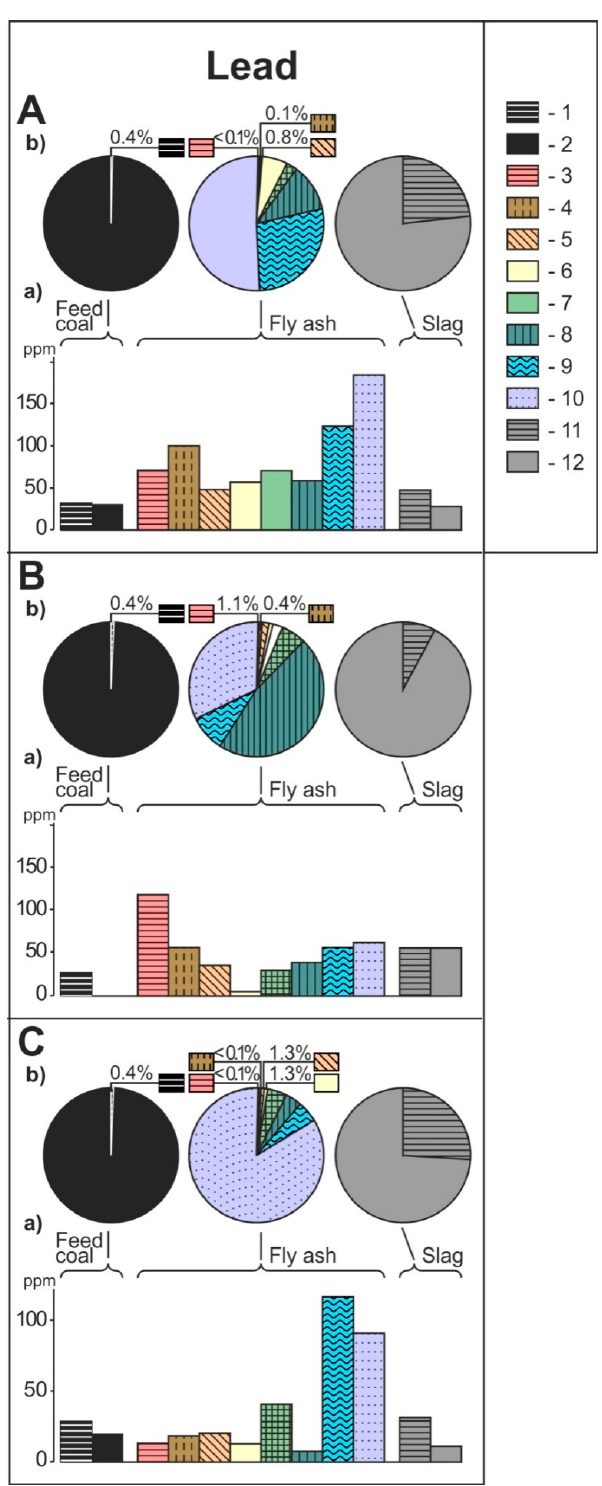
Figure 2. The distribution of element content in the feed coal, fly ash and slag ( a ) and their proportion in determining the average element concentration in the whole feed of coal, fly ash and slag ( b ). * Fractions: 1—magnetic and 2—nonmagnetic fraction of the feed coal, 3–10 fly ash: (3—magnetic and 4—nonmagnetic fraction >0.5 mm, 5—magnetic and 6—nonmagnetic fraction 0.5 ÷ 0.2 mm, 7—magnetic and 8—nonmagnetic fraction 0.2 ÷ 0.05 mm, 9—magnetic and 10—nonmagnetic fraction <0.05 mm), 11—magnetic and 12—nonmagnetic fraction of the slag.